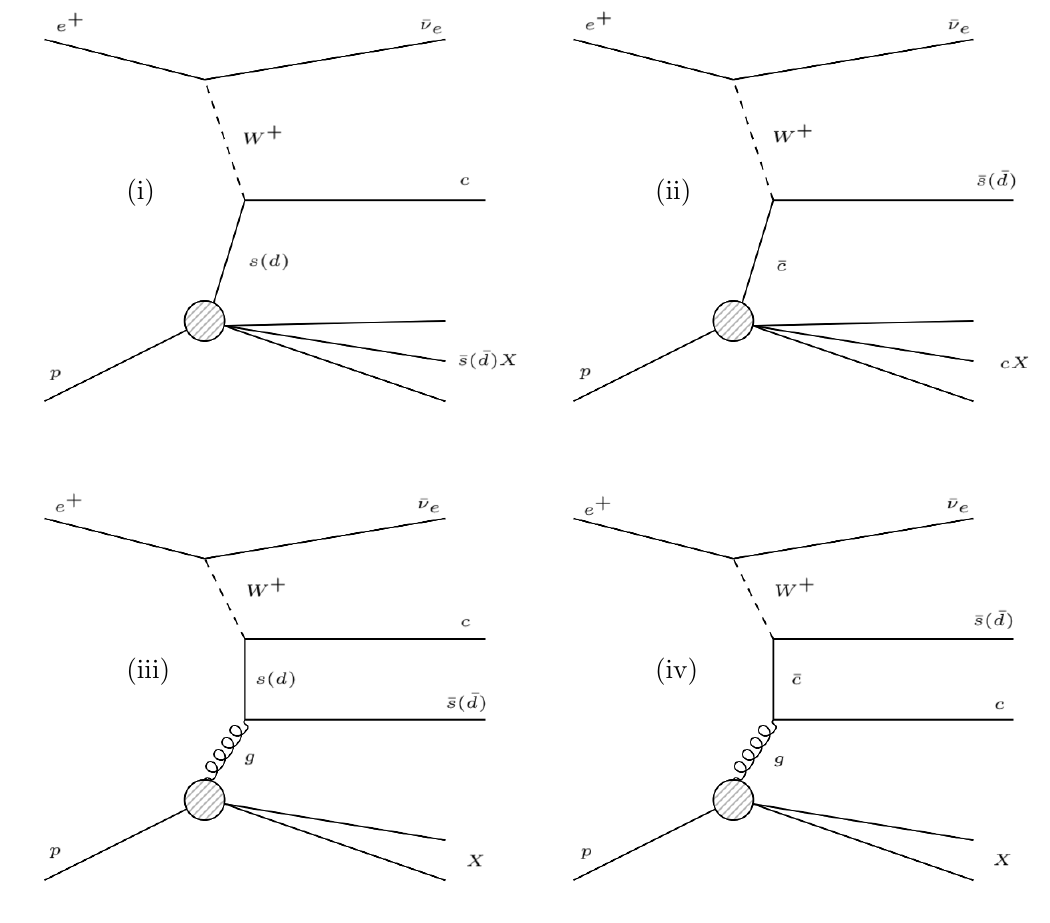
Figure 1. Feynman diagrams of charm-production subprocesses in e + p collisions. The QPM process illustrated in (i) describes s ( d ) ! c transitions. In the QPM process (ii) (cid:22) c ! (cid:22) s ( (cid:22) d ),